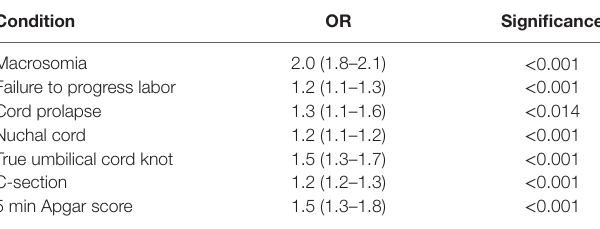
TAble 1 | Odds ratio (OR) for males regarding gestational conditions that alter fetal progression in labor after Sheiner et al. (11). Condition OR